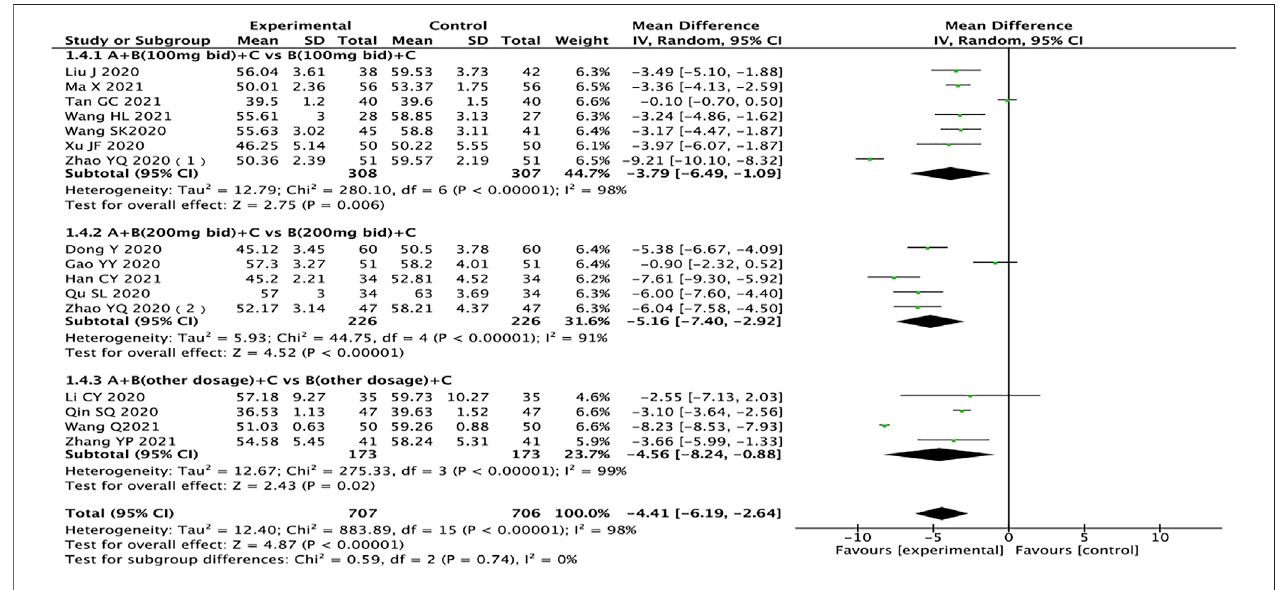
FIGURE 6 | Forest plot of LVEDD.